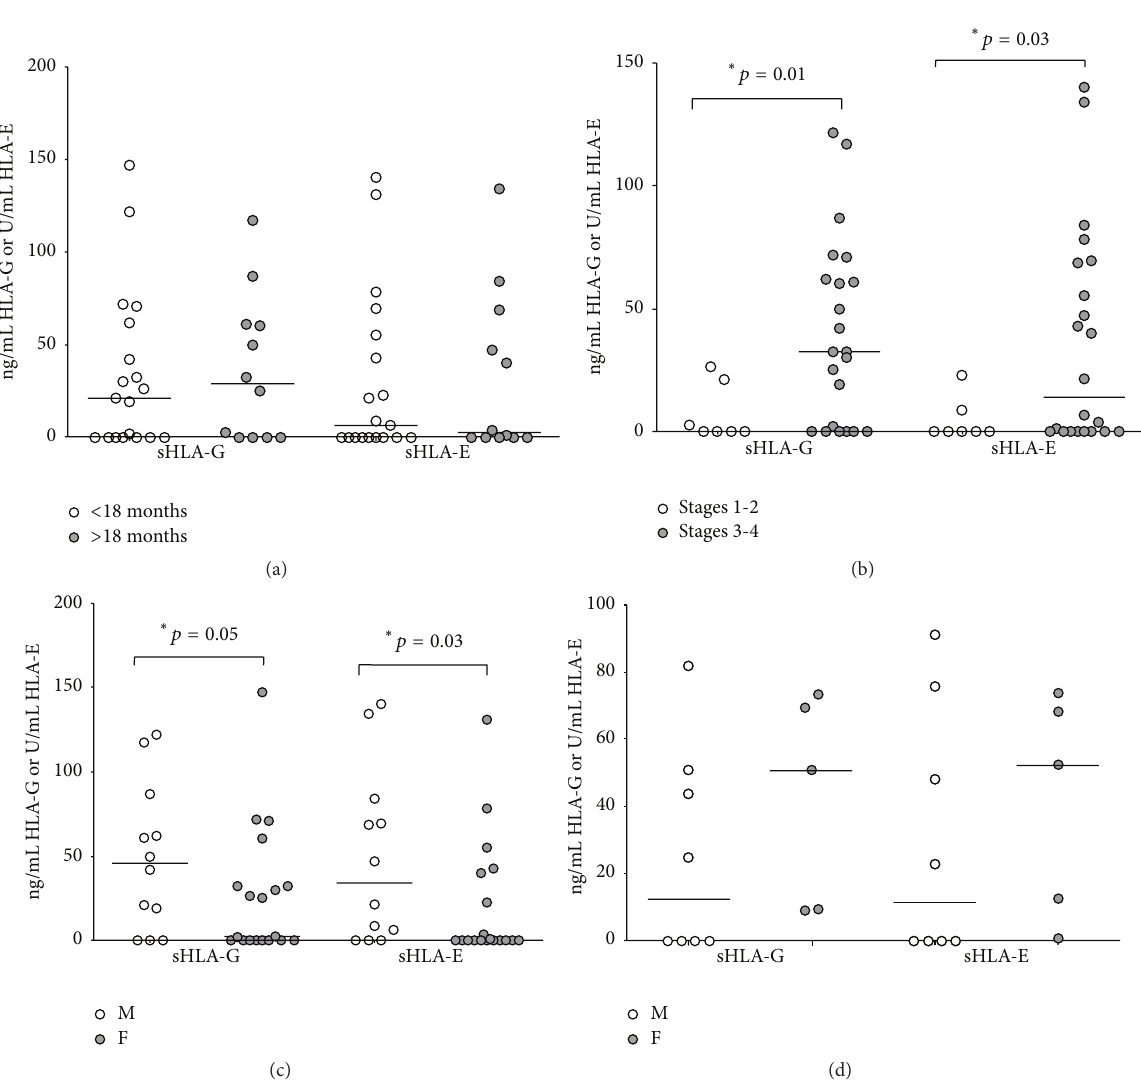
Figure 3: Levels of soluble (s)HLA-G and sHLA-E in BM plasma samples have been analyzed in patients with age at diagnosis above (grey circles) or below (white circles) 18 months (a) and in patients with stages 3-4 (grey circles) or 1-2 (white circles) disease (b). Differences between female (grey circles) or male (white circles) subjects have been analyzed in NB patients (c) and healthy donors (d). Horizontal lines indicated medians. Results are expressed as ng/ml (sHLA-G) or arbitrary units (U)/ml (sHLA-E). p values are indicated where differences are statistically